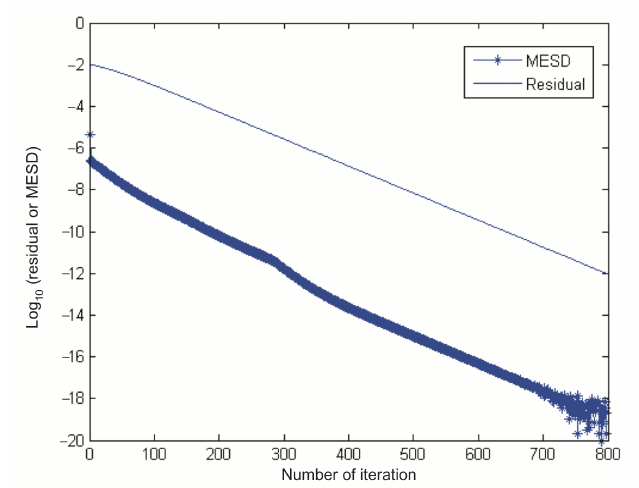
Fig. 2. Residual history for Example